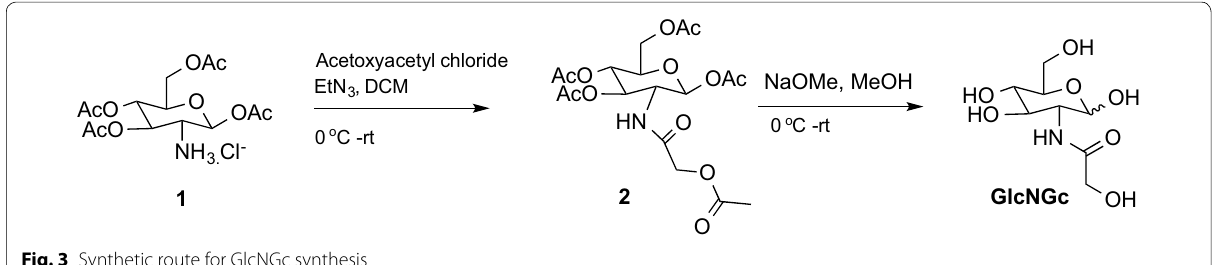
Fig. 3 Synthetic route for GlcNGc